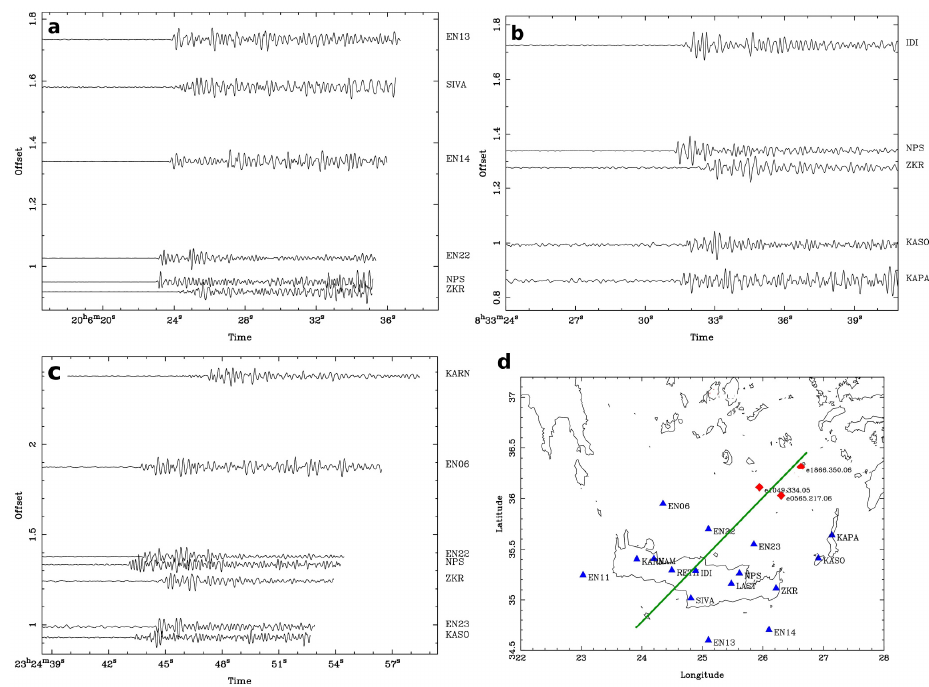
Fig. 15: Examples of time-reduced seismograms for intermediate depth events recorded at stations located in the forearc of the Hellenic subduction zone as shown in the event and station map in (d) . (a) Event e0565.217.06, depth 87 km; (b) event e1049.334.05, depth 99 km; (c) event e1866.350-06, depth 110 km. Note the multi-onset character of the P phases and the generally long complex wave trains. Red diamonds in (d) show event epicenters and green line indicates possible profile for a seismic